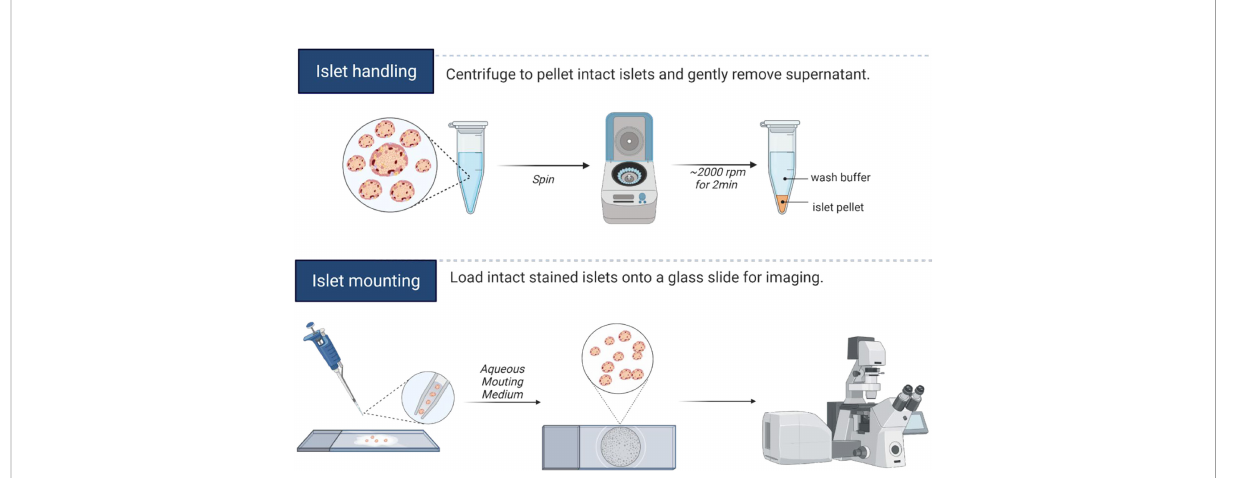
FIGURE 1 Islet handling tips for immunostaining. Isolated islets can be pelleted by centrifugation, and the entire staining protocol can be completed in microcentrifuge tubes. Care should be taken to not disrupt the islet pellet when aspirating wash fl uids. We recommend leaving residual liquid above the islet pellet to prevent unintentional islet loss. For mounting whole islets, hand-transfer islets from low-adhesion staining tubes onto a glass slide, aspirate away excess liquids by pipette, then cover islets with 1-2 drops of mounting media and coverslip, taking care not to let islets dry out completely during the mounting process. A hydrophobic barrier pen may be useful in marking the islet boundary to prevent islet spread on the slide and to facilitate islet identi fi cation during imaging. Graphics created in